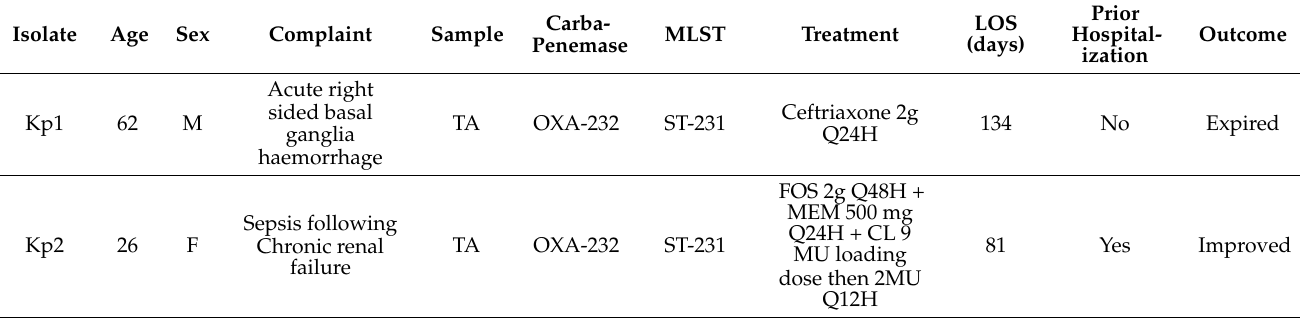
Table 1. Demographic and clinical profiles of the